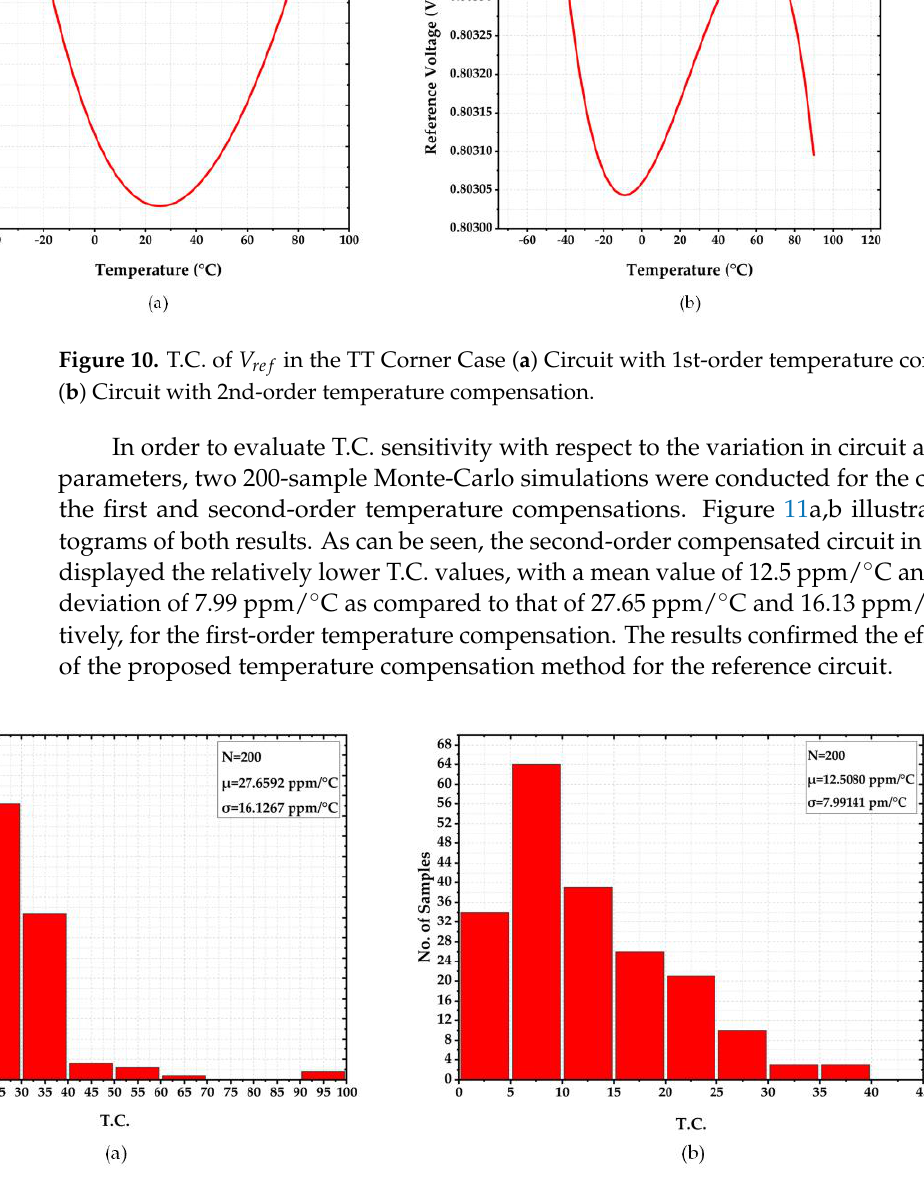
Figure 11. Monte-Carlo Simulation of T.C. ( a ) Circuit with 1st-order temperature compensation ( b ) Circuit with 2nd-order temperature compensation.